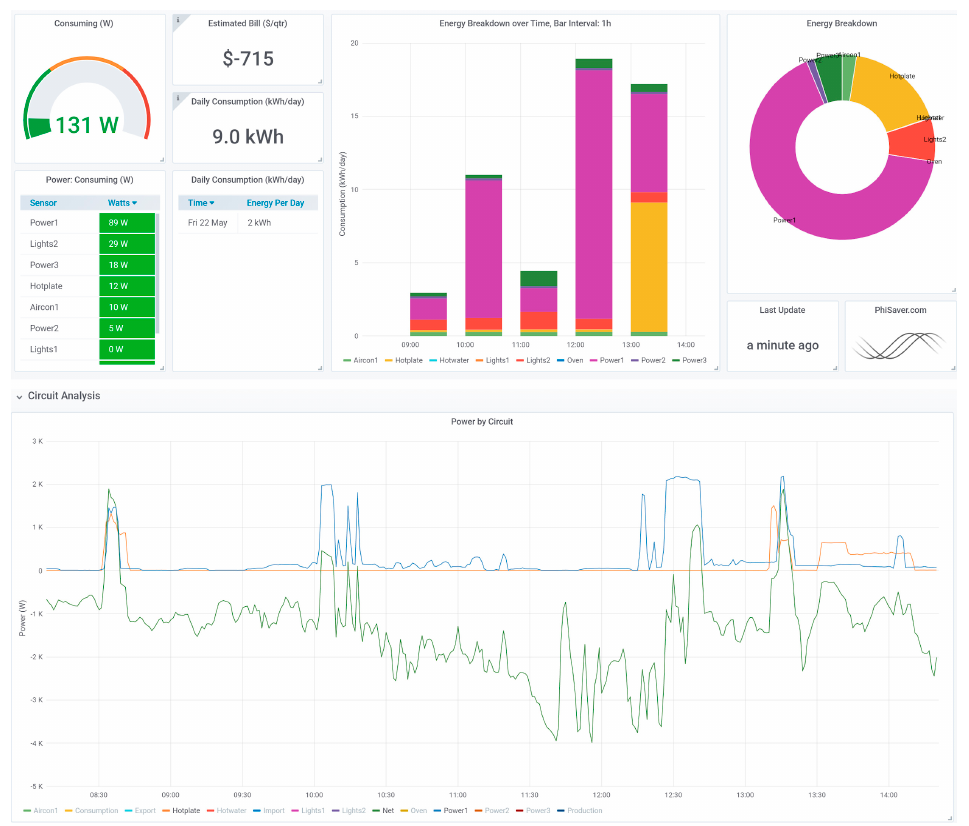
Figure 1. Phisaver energy monitoring interface available to all participants, PC view.